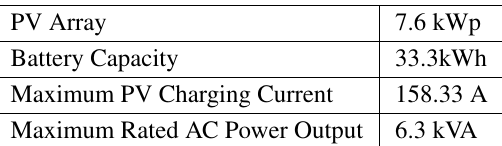
Table 3. Sizing Result for the RO unit